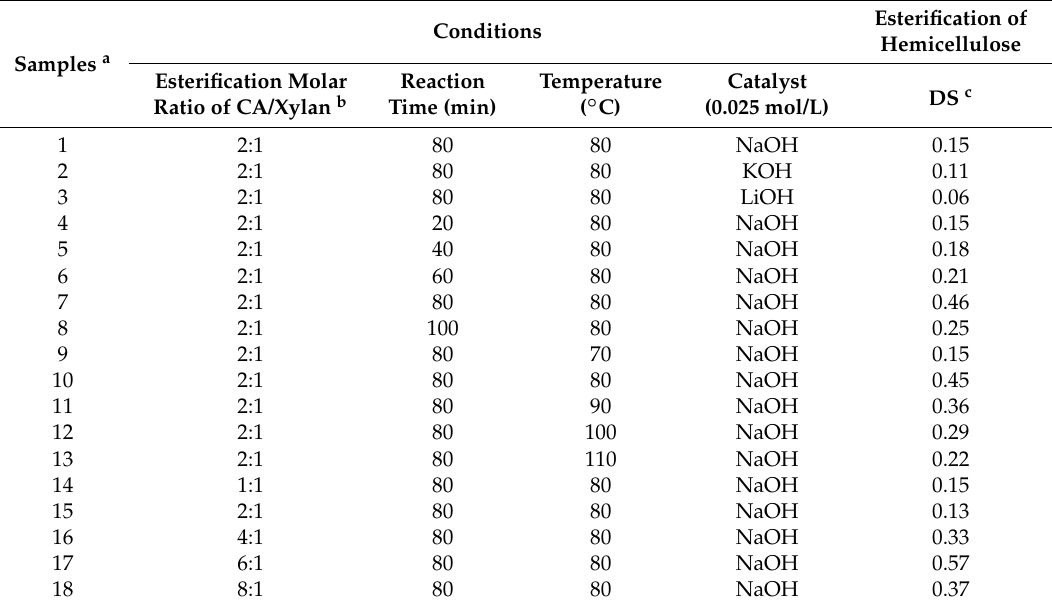
Table 1. The degrees of substitution (DS) of the cinnamic anhydride xylan (CAX) obtained by the reaction of xylan with cinnamic anhydride (CA) in various reaction conditions.